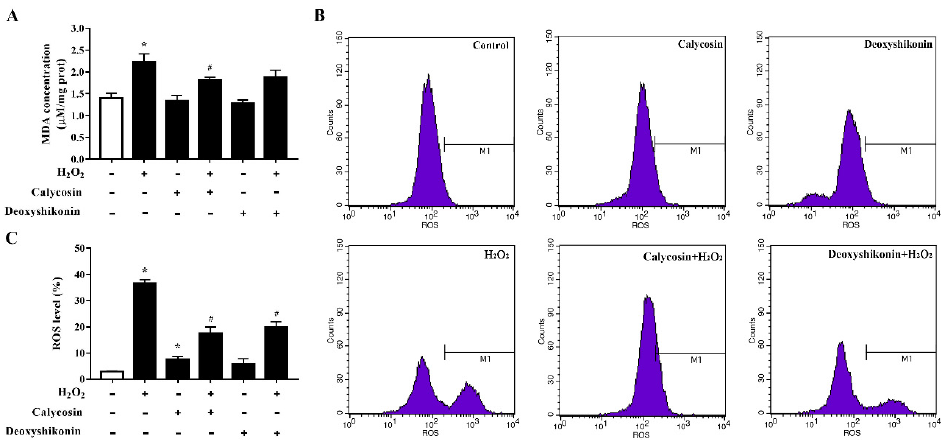
Figure 4. Effects of the hit compounds on H 2 O 2 -induced malondialdehyde (MDA) and reactive oxygen species (ROS) production in IPEC-J2 cells. IPEC-J2 cells were pretreated, and not pretreated, with calycosin or deoxyshikonin for 24 h, then with 1000 µ M H 2 O 2 for 4 h. Nontreated cells served as a control. ( A ) MDA concentrations were determined using an MDA assay. ( B ) Flow-cytometric analysis of ROS. ( C ) Quantification of ROS based on flow cytometry data. Data represent the mean ± SEM of three independent experiments. Differences between two groups were determined using Student’s t -tests. * p < 0.05 vs. nontreated control cells; # p < 0.05 vs. H 2 O 2 -treated